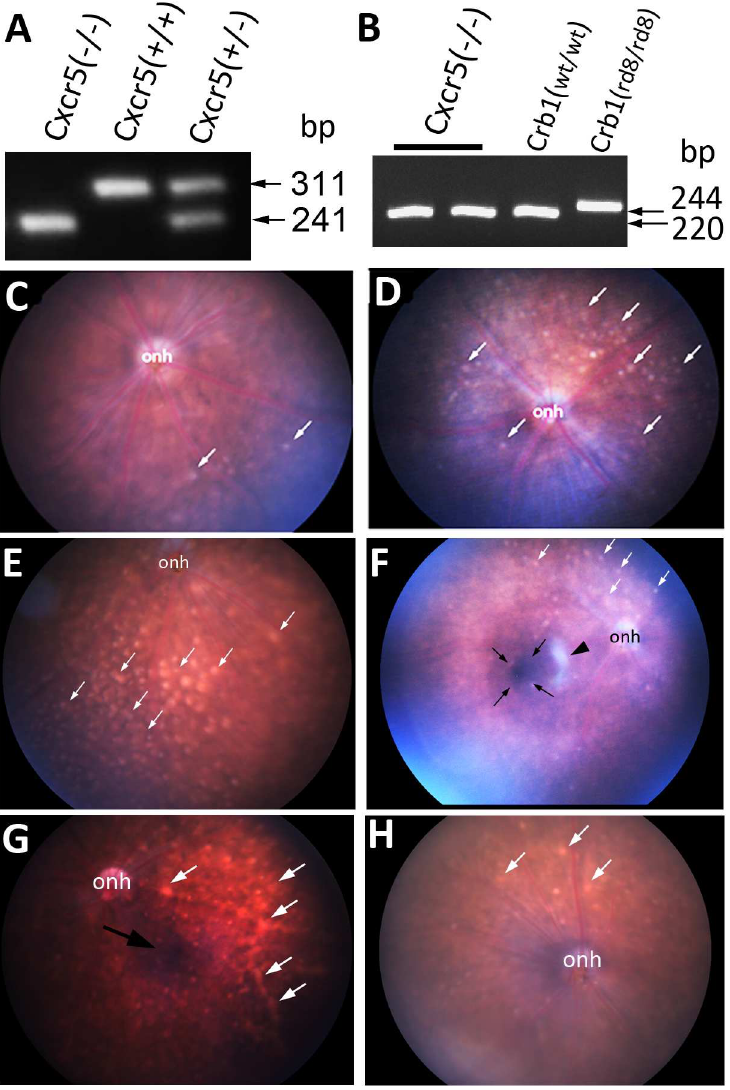
Fig 2. Fundus abnormalties in aged Cxcr5 -/- mice. ( A ) PCR genotyping results for Cxcr5 gene. ( B ) PCR genotyping results for Crb1 gene.( C-H ) Representative fundus images of Cxcr5 -/- mice at the ages of 5 months old ( C ), 9 months old ( D ), 12 months old ( E ), 17 months old ( F ), 22 months old ( G ), and the 22-month- old C57BL/6wild type (WT) control mice ( H ). White arrows ( C-H ) denoteddrusen-likespots. Black arrows ( F & H ) denotedthe possiblehyperpigmentation. Black arrowhead ( F ) denotedthe possiblehypopimgmentation. onh: opitcalnerve head. Four to eight mice from each group were used for retinal fundus